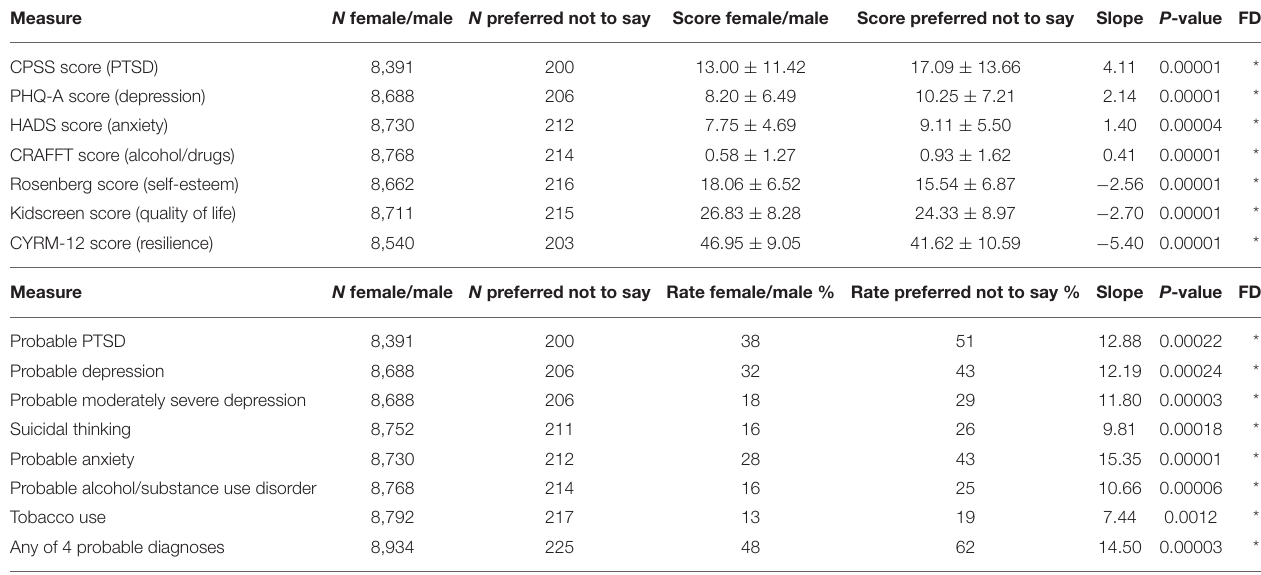
Tableshowsparticipantnumbers,summarystatistics,andresultsofanalysisofeffectsofpreferrednottosayvs.female/malegenderidentity.NXcolumnsindicatenumberofparticipants identifying as gender X (preferred not to say or female/male). Score X columns show mean ± standard deviation (not standard error) for gender X. Rate X columns indicate rates of probable diagnosis for gender X. Slope is the fitted slope parameter from a linear model with time and age partialled out (see discussion of nuisance variables in the Materials and Methods). The slope parameter indicates the linear relationship between the preferred not to say vs. female/male effect variable and the dependent variable, independent of time and age. P-values were derived from permutation testing on the slope parameters. Comparisons with an asterisk under the FDR column survived FDR multiple comparison